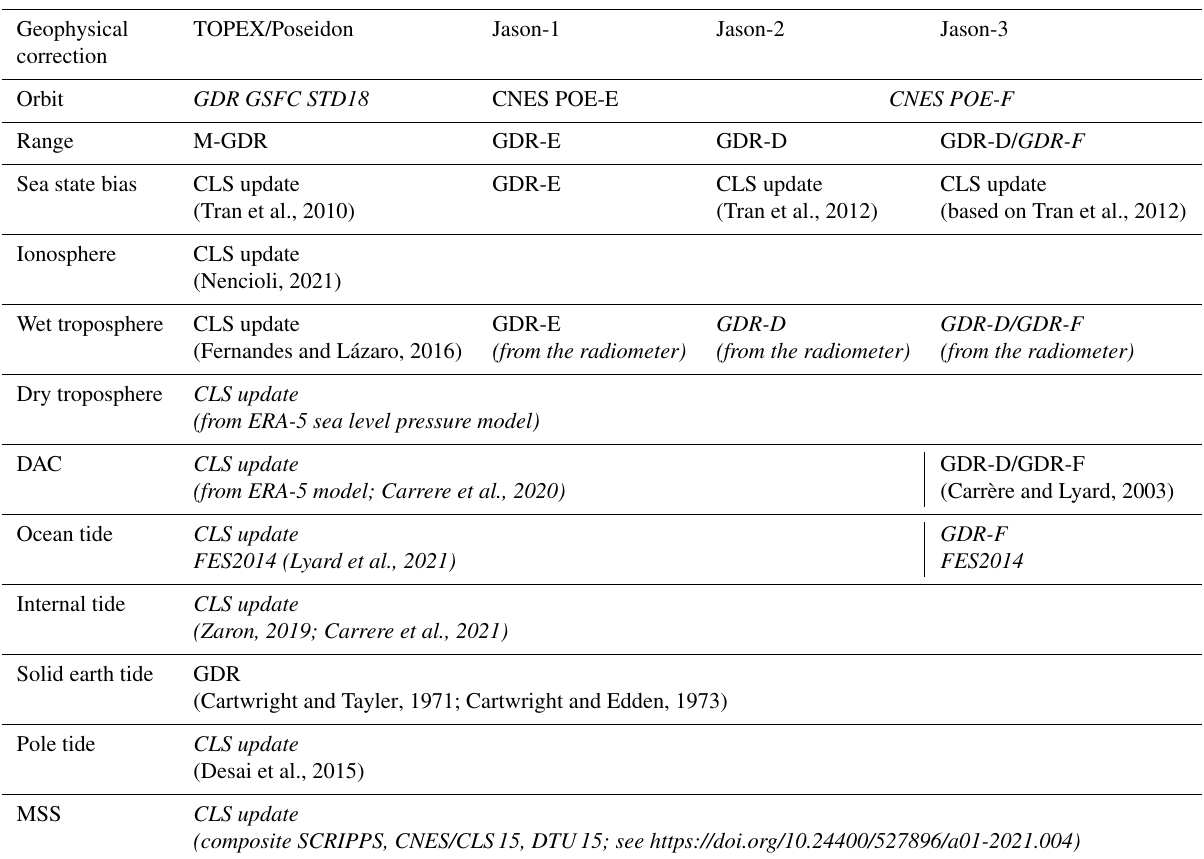
Table 1. Origins and references of the corrections contained in the L2P21 along-track 1Hz products. These products are the ones used to compute the current GMSL CNES/AVISO+ record. The terms in italics are the ones updated as compared to the previous version L2P18.